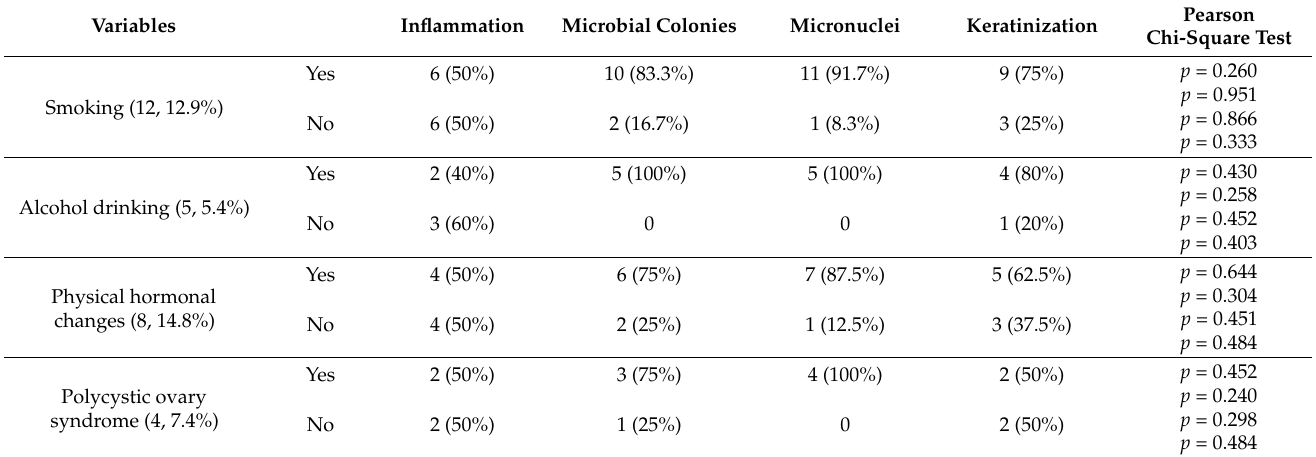
Table 3. The distribution of habits and hormonal changes in response to various cytopathological findings.